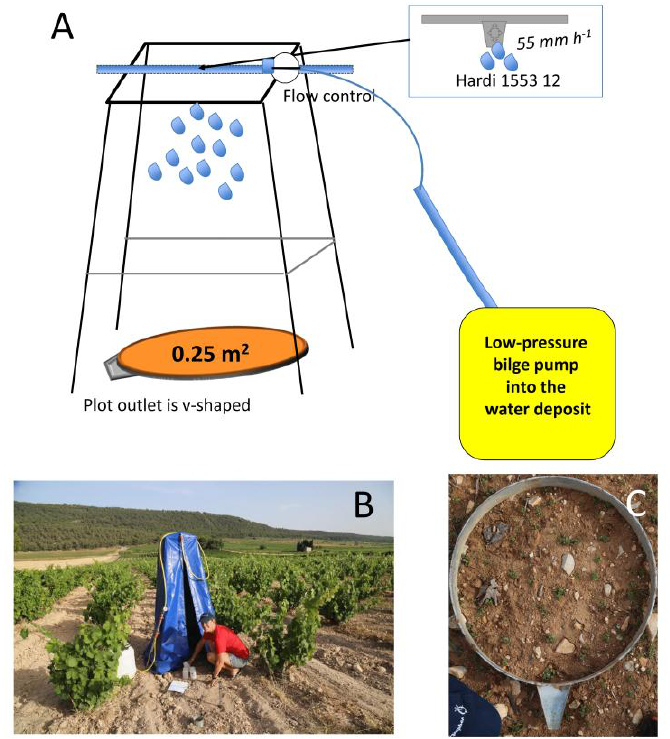
Figure 2. Rainfall simulator ( A , B ) and ring plot ( C ).